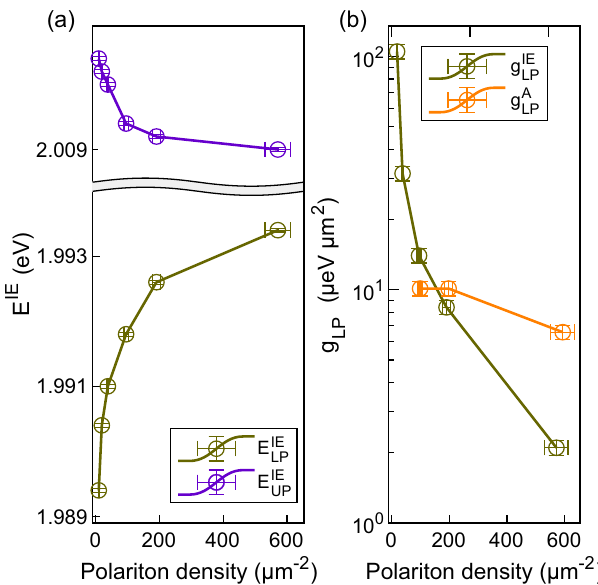
Fig.3|ComparisonofnonlinearityoftheIEpolaritonwithAexcitonpolariton. a Energy of the lower and upper branch of the IE polariton as a function of the polariton density at zero-detuning k ∥ . The movement of the lower branch is more than the upper branch due to the combined effect of exciton-exciton interaction and saturation. The error bars in energy represent the uncertainty in determining thepeakoftheLorentzian fi t(polaritonenergy)tothere fl ectiondata. b g IE LP (g A LP )as a function of the IE (A) lower branch polariton density at zero-detuning k ∥ . g LP is de fi ned as the local slope of the polariton energy vs. polariton density graph. g A LP and g IE LP are calculated from the lower branch of A polariton and IE polariton, respectively. Note thatthe g LP of IE polariton~(100±2) μ eV μ m 2 isalmost 10 times larger than the g LP of A exciton polariton~(10±0.2) μ eV μ m 2 . All the power- dependent nonlinear measurements were carried out using a pulsed super- continuum laser (20 ps pulsewidth) with proper bandpass fi lter in the input to exciteonlyonepolaritonspecies.Thepolaritondensitycorrespondstothespeci fi c branch being excited. The density error bars take into account the error in mea- suring power and determining the energy of the polariton and linewidth from the Lorentzian fi ts. The error bars in g LP consider the error in determining the density and the energy of the